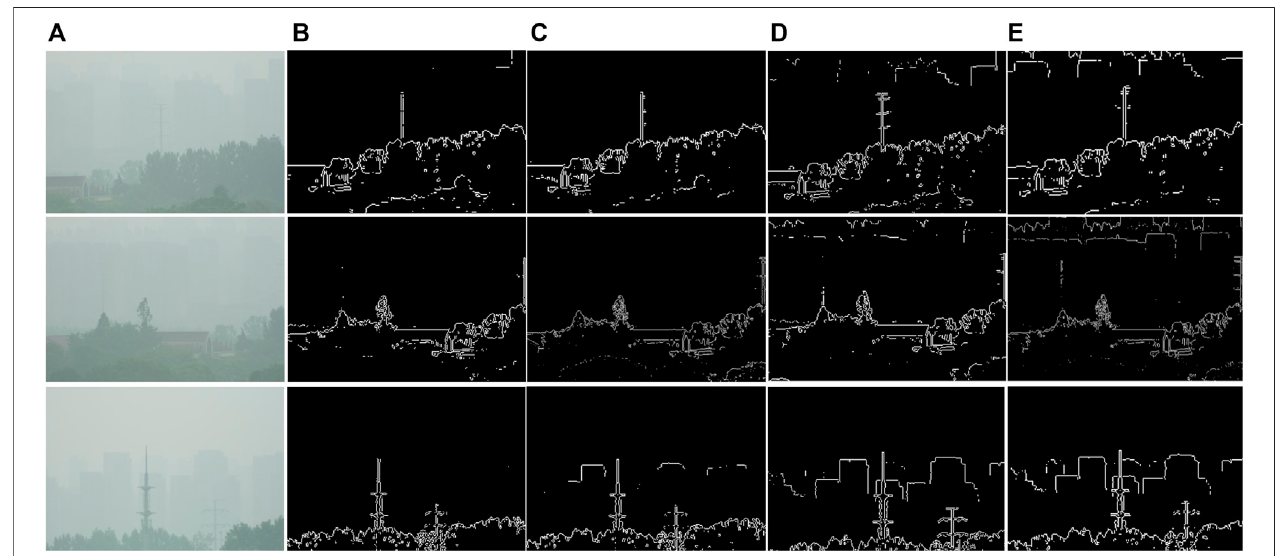
FIGURE 5 | The result of edge detection by using the Prewitt operator after dehazing. (A) Original scene image. (B – E) The edge extraction result of the original image, the AOD-Net dehazing result, the DCP dehazing result, and the dehazing result of our method respectively.